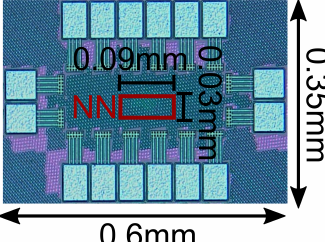
Figure 7. Chip micro-photograph of proposed cancer